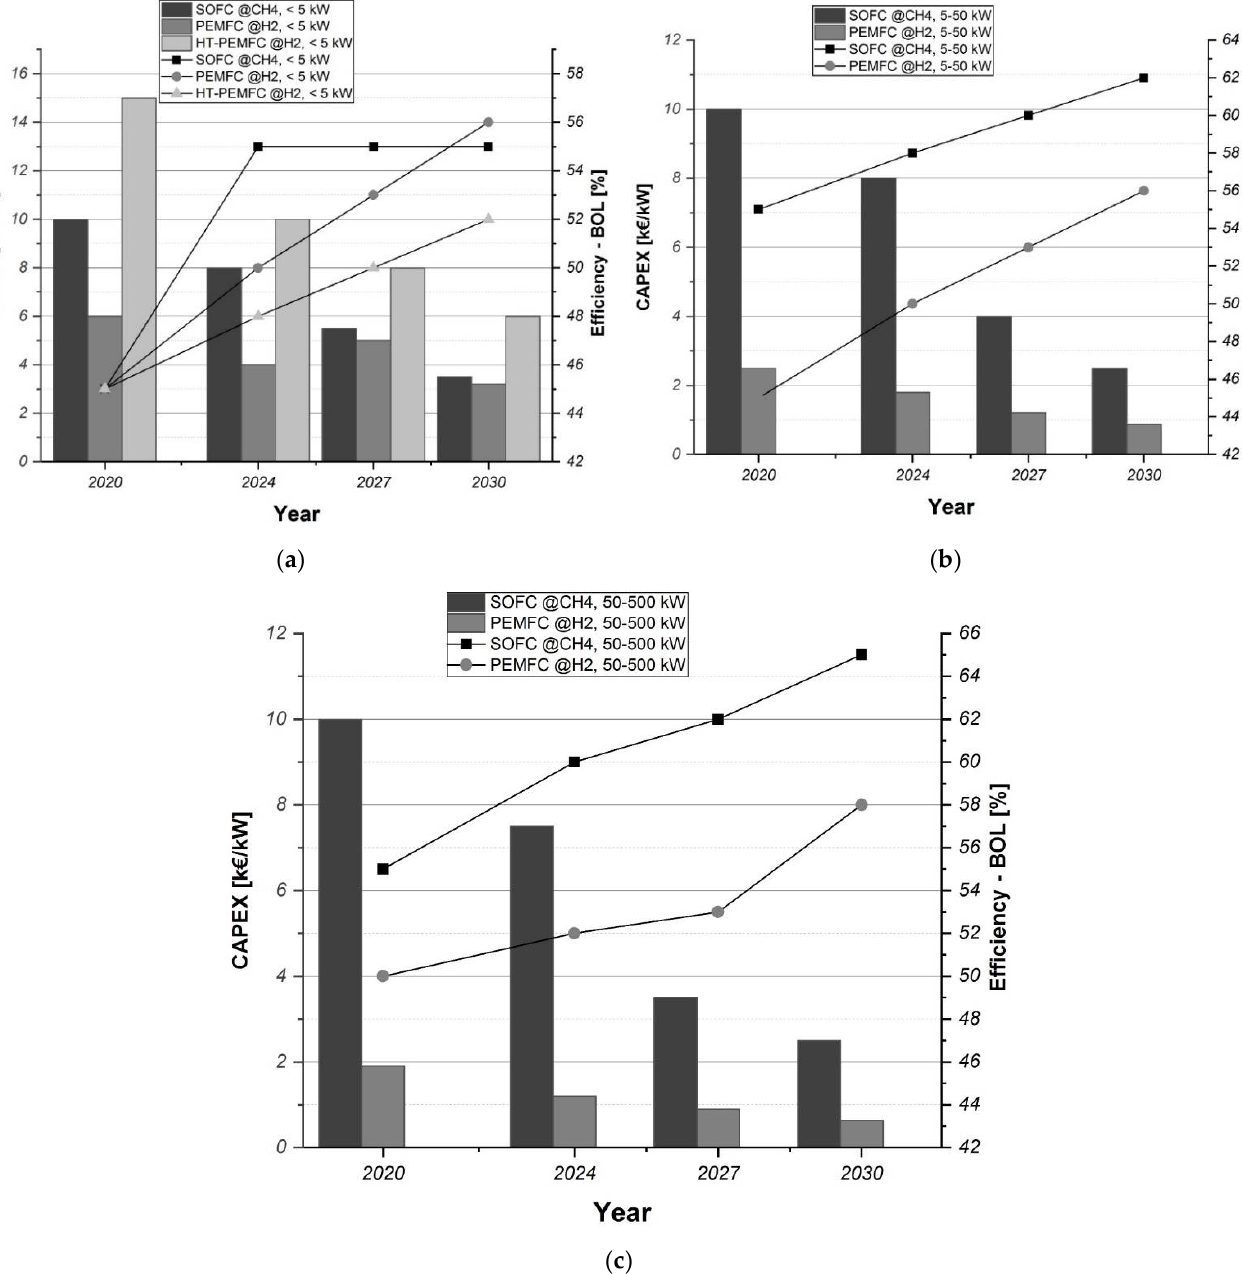
Figure 10. European Scenario, CAPEX and Efficiency Forecasts for less than 5 kW el units ( a ), units with a size between 5 and 50 kW el ( b ), and between 50 and 500 kW el ( c ).